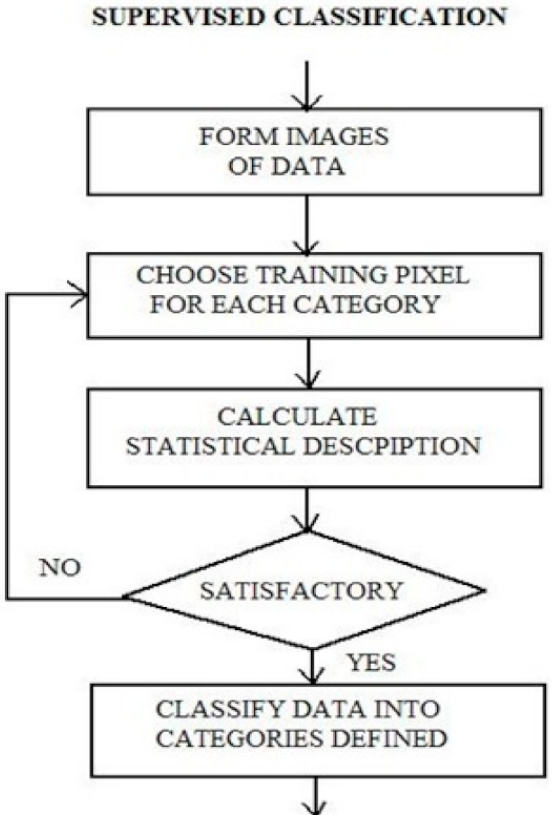
Figure 4. Logic and steps in supervised classification.